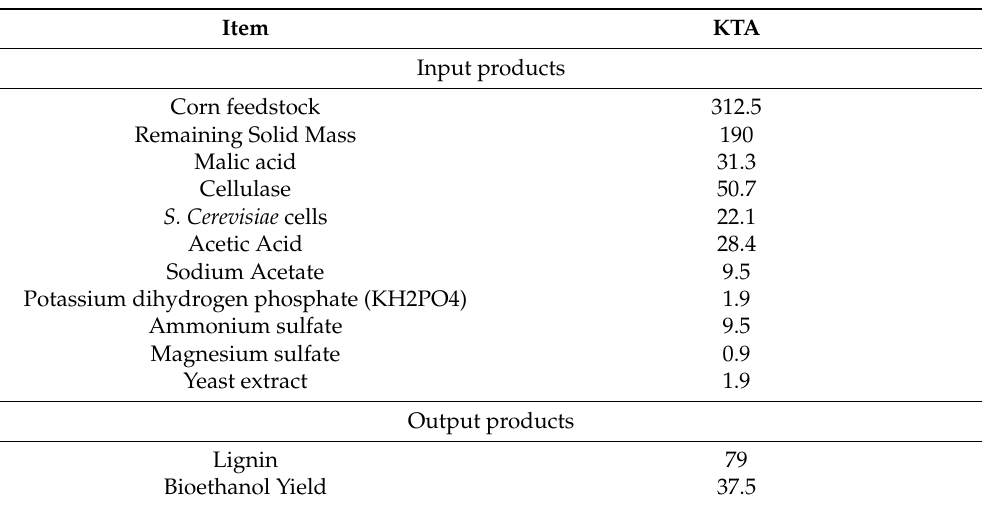
Table 8. Raw materials that are required for a 50 KTA of bioethanol